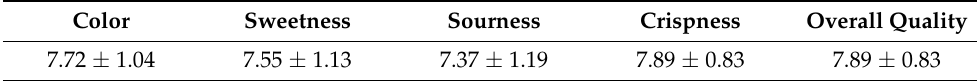
Table 2. Sensory evaluation of mango slices using hot air